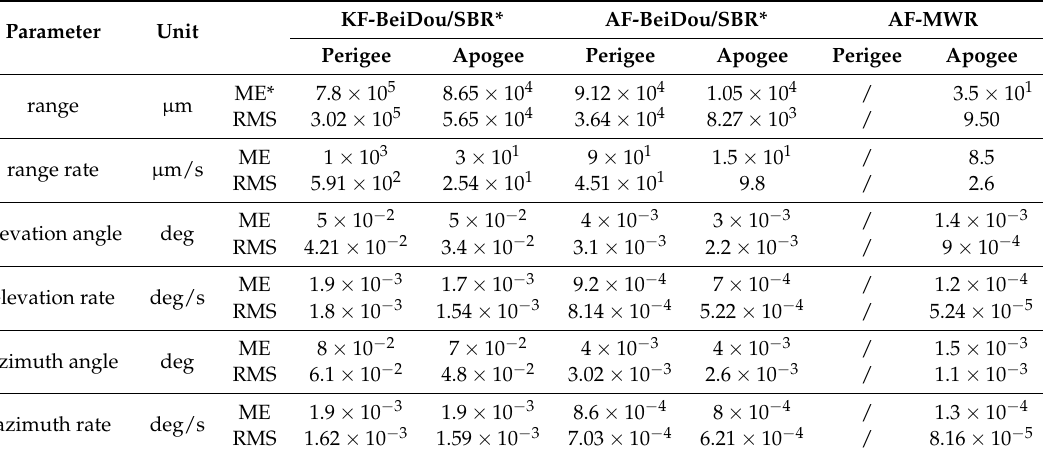
Table 4. Relative navigation estimation error during